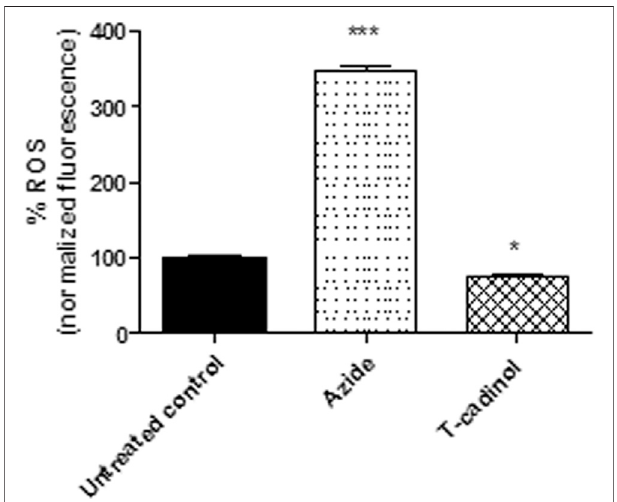
FIGURE 6 | - Evaluation of reactive oxygen species (ROS) production in T. cruzi trypomastigotes treated with compound 1 (T-cadinol − 18.2 μ M) for 4 h H 2 DCFDA dye fl uorescence was measured spectro fl uorimetrically (excitation 485 nm and emission 535 nm). Untreated trypomastigotes wereusedasanegativecontrol,andthosetreatedwithsodiumazide(10 mM) as a positive control. Fluorescence was normalized with respect to untreated trypomastigotes (100%). *** p < 0.0001 and p < *0.05.